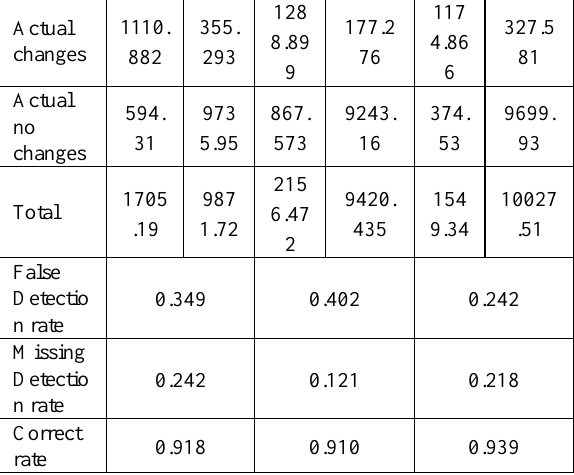
Table 1. Accuracy comparison by method with different weights